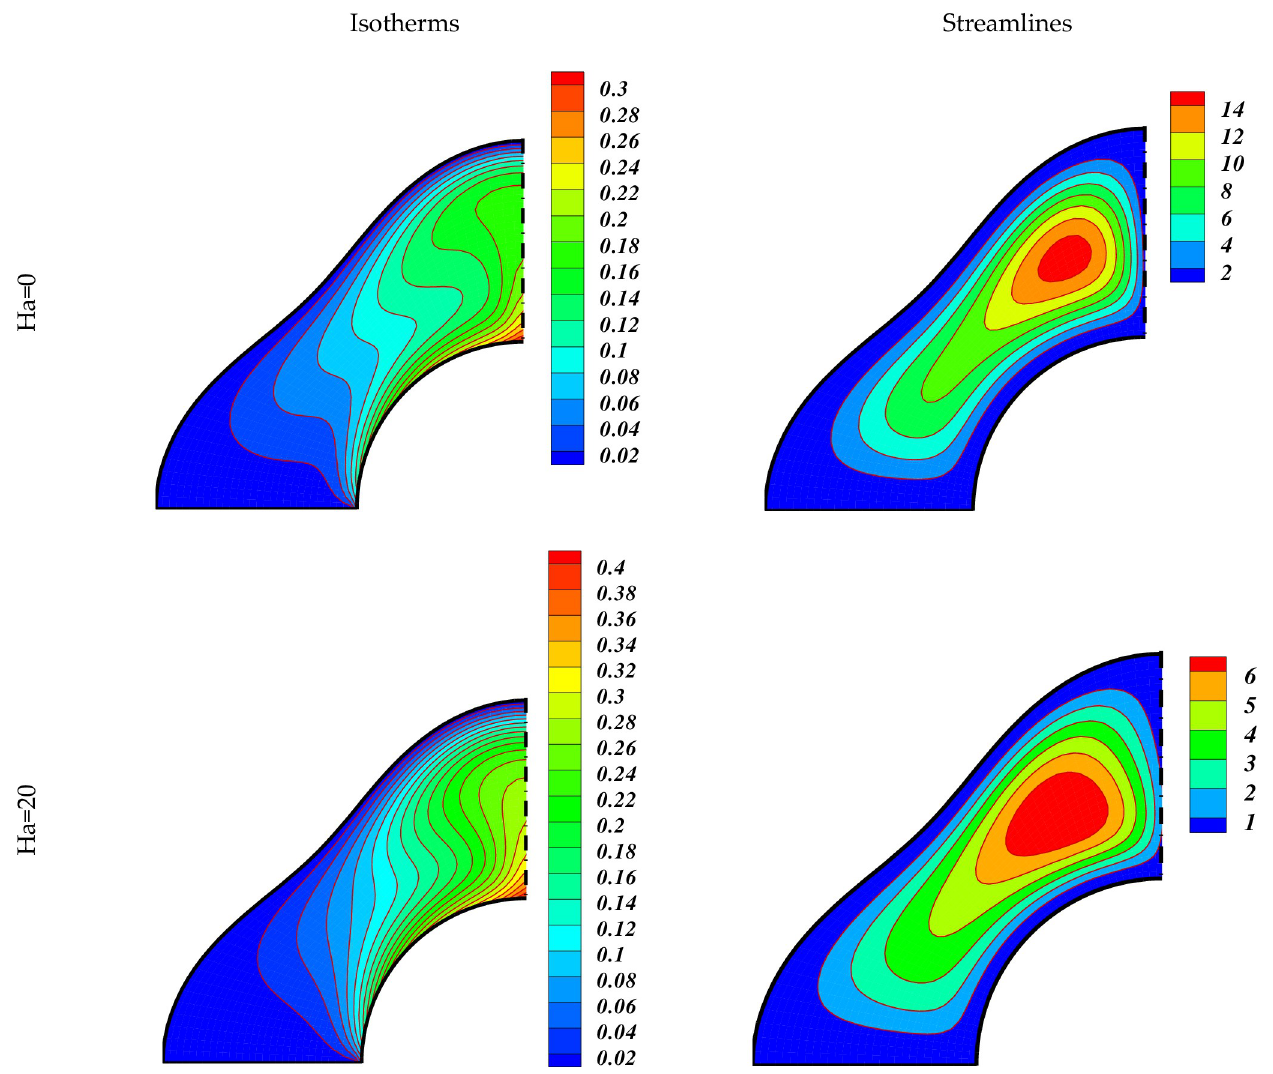
Fig 5. Impact of Ha on the flow when Ra = 10 5 , Rd = 0 . 8 , Da = 100 .